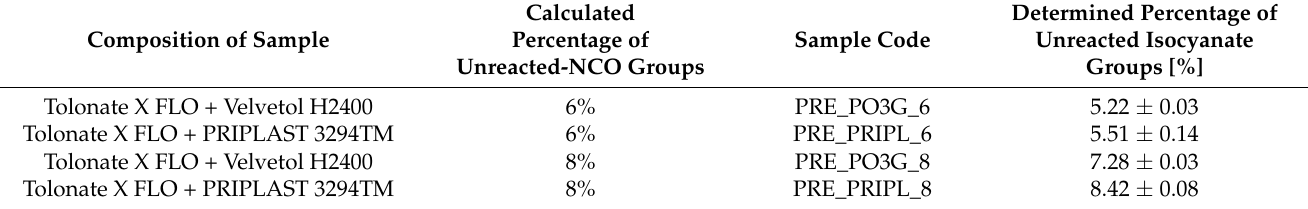
Table 1. NCO content.